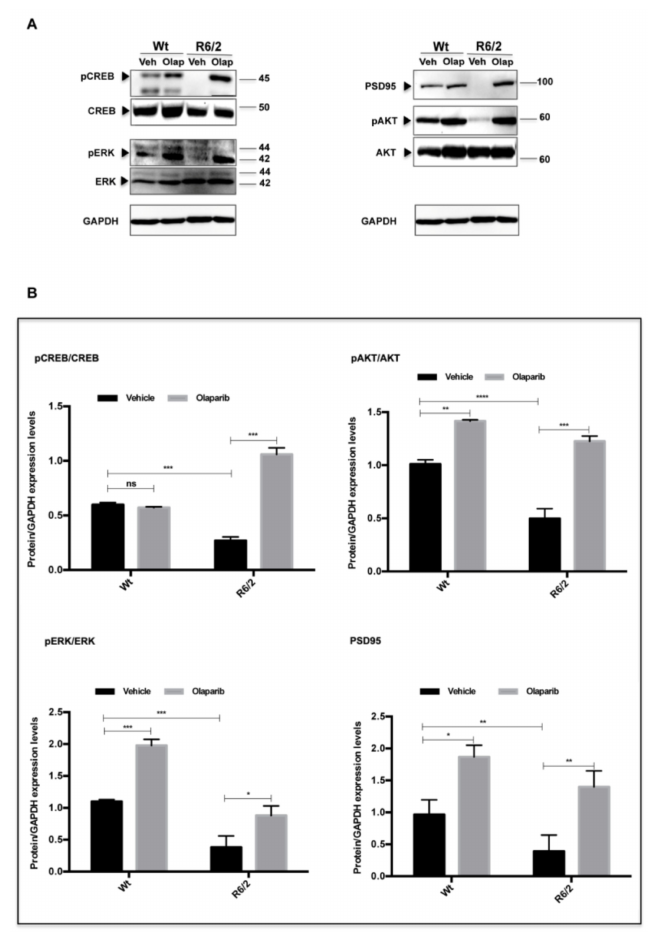
Figure 3. Olaparib promotes neuroprotection in R6 / 2 mice. ( A ) Brain tissue homogenates of all experimental groups were subjected to Western blotting analysis using pCREB, pERK, pAKT, and PSD-95. GAPDH was used as the loading control. Blots are representative of ≥ 3 independent experiments performed on 8 animals per group. ( B ) Graphs representing each protein expression level show that Olaparib treatment restored the phosphorylation of CREB (F 1,68 = 4.791 p < 0.001), ERK (F 1,68 = 29.77 p < 0.001), and AKT (F 1,68 = 39.27 p < 0.001), promoting striatal neurons survival. Moreover, Olaparib was able to prevent post-synaptic modification in the R6 / 2 mice compared